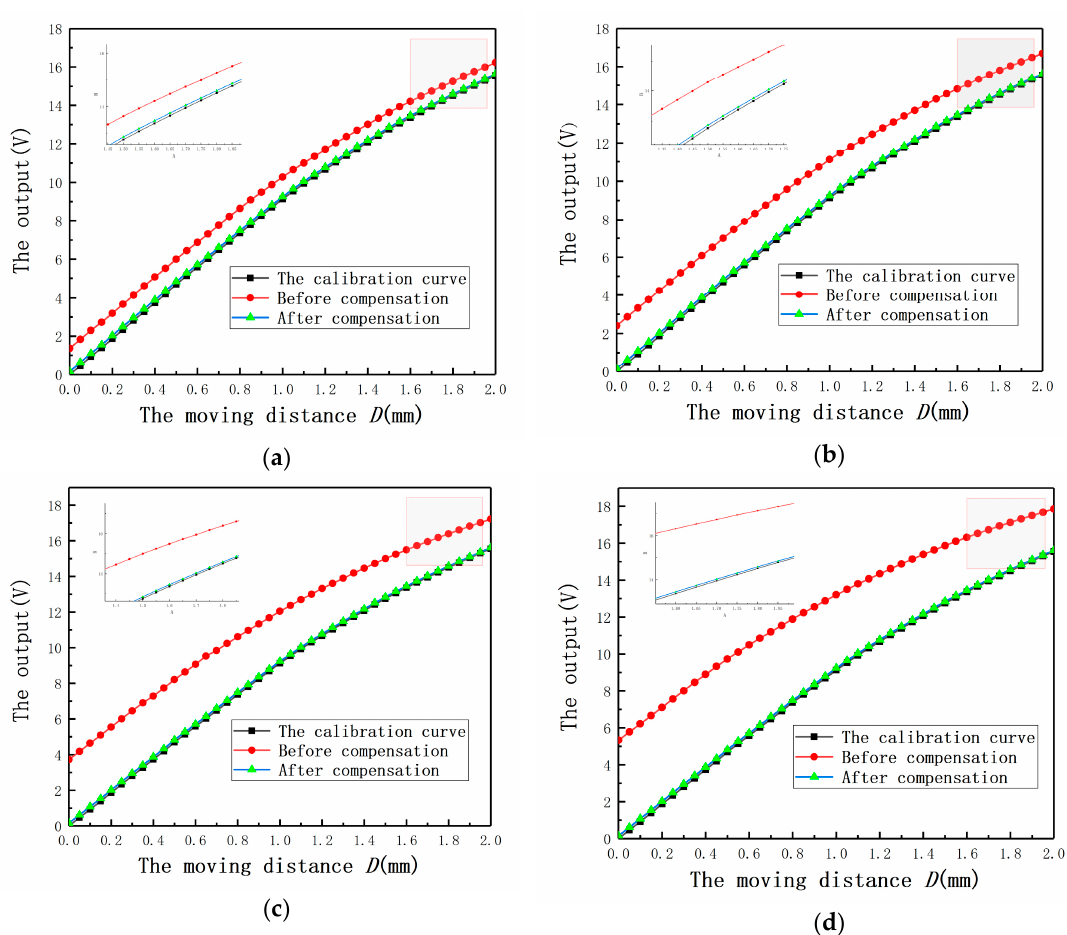
Figure 22. The output curves with and without compensation under different eccentricities: ( a ) E = 3 Figure22. Theoutputcurveswithandwithoutcompensationunderdi ff erenteccentricities: ( a ) E = 3mm; mm; ( b ) E = 4 mm; ( c ) E = 5 mm; ( d ) E = 6 mm. ( b ) E = 4 mm; ( c ) E = 5 mm; ( d ) E = 6